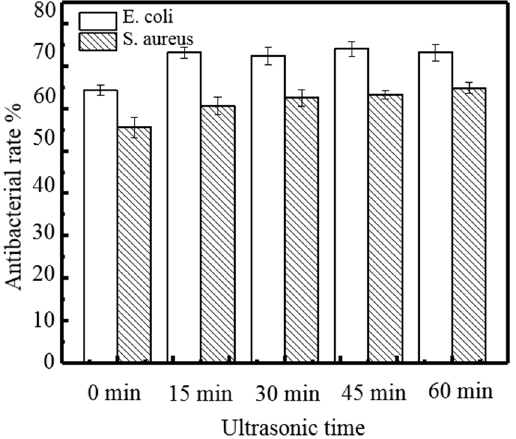
Figure 9. Effect of ultrasound times effect on the antibacterial rate of the film.